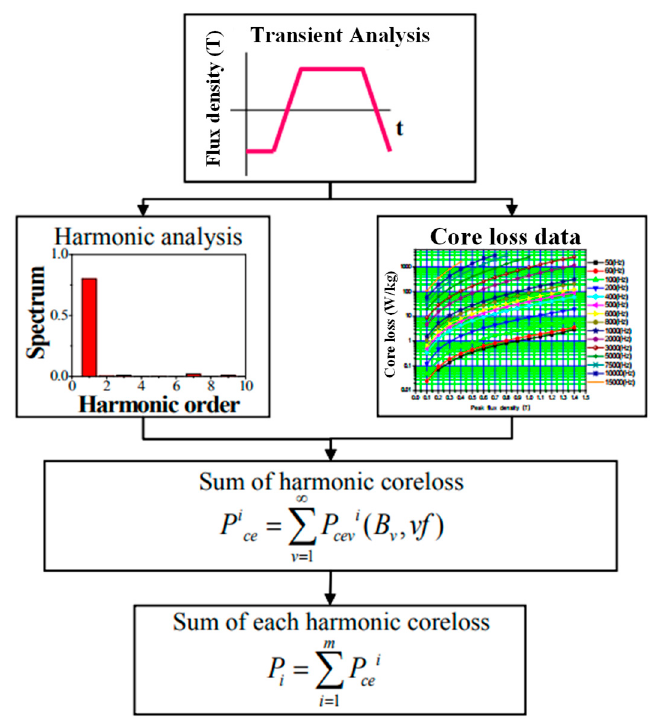
Figure 10. Calculation process of core loss.